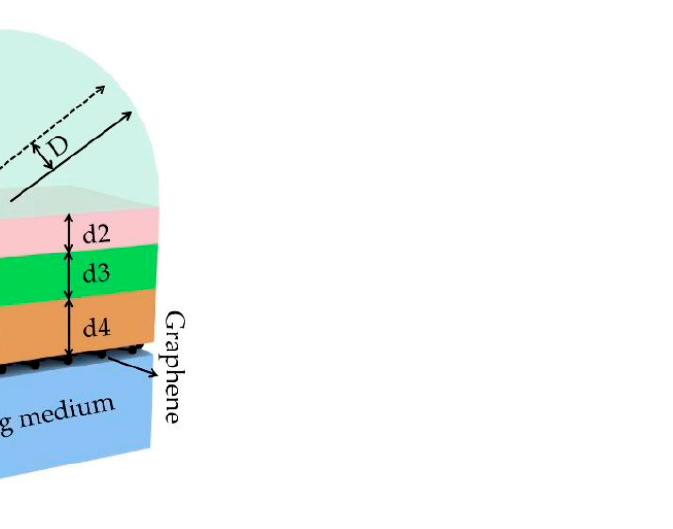
Figure 1. A bimetal structure based on graphene-hexagonal boron nitride (graphene-hBN) of schematic diagram.